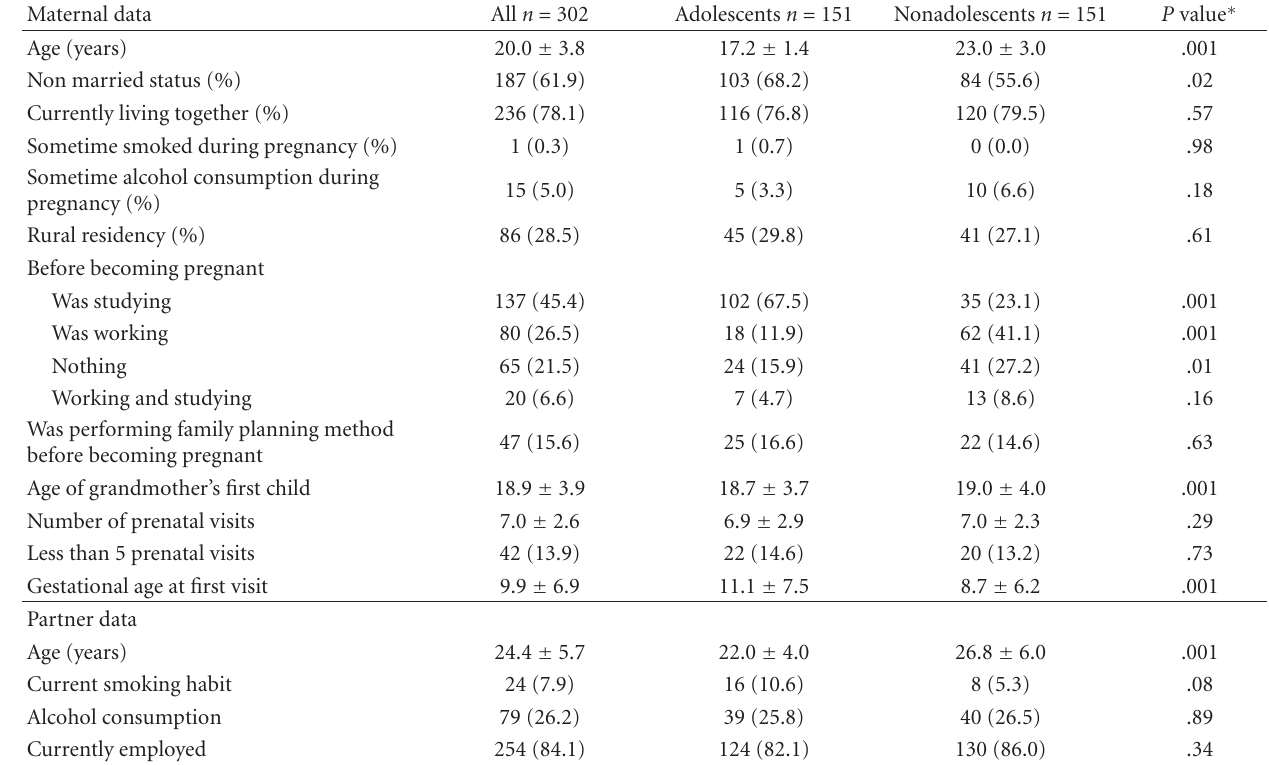
Table 1: General demographic characteristics of studied women.